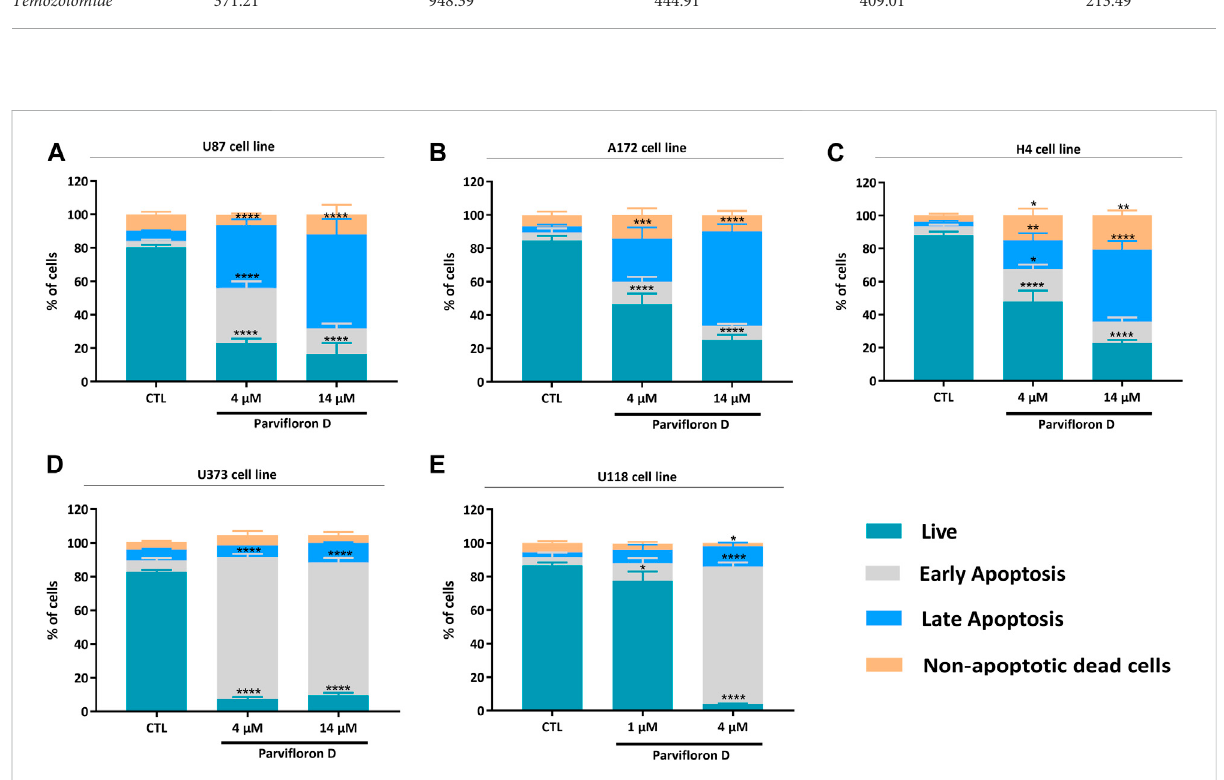
FIGURE 3 Assessment of cell death pro fi le in U87 (A) , A172 (B) , H4 (C) , U373 (D) , and U118 (E) cell lines by fl ow cytometry. Cells were treated with parvi fl oronDandfurtherincubatedfor48 h.Afterincubation,cellswereco-stainedwithAnnexinVandPIandthepercentageofnon-apoptoticcells or cells in apoptosis was determined. Asterisks (* p < 0.05, ** p < 0.01, *** p < 0.001, and **** p < 0.0001) represent the values that signi fi cantly differ from the values obtained for the control group (untreated cells). These results are representative of at least fi ve independent experiments and data expressed as mean ±